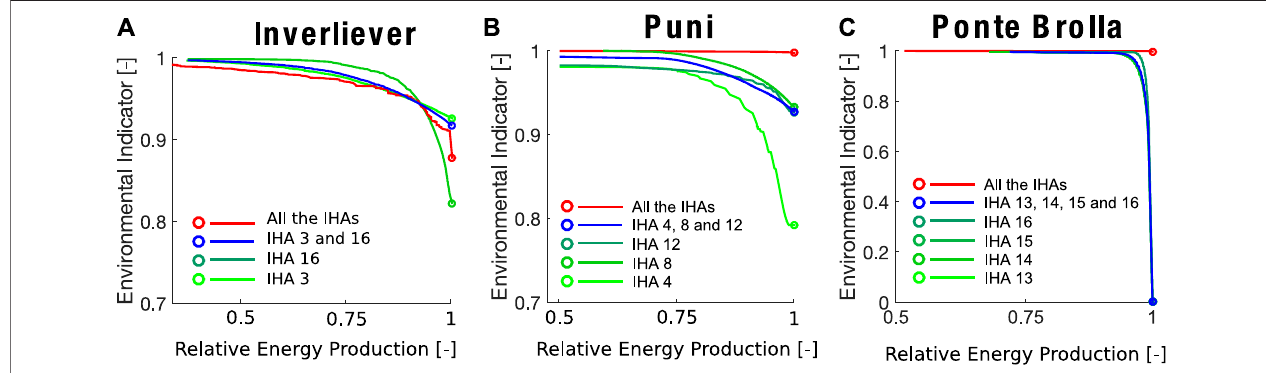
FIGURE 5 | Contribution of the IHA with the highest variability identi fi ed in Table 4 to compute the new Pareto Frontier (blue curve). The red curve represents the original Pareto Frontier that would be obtained if all the IHAs were taken into account. The dots represent Q mfr policies.